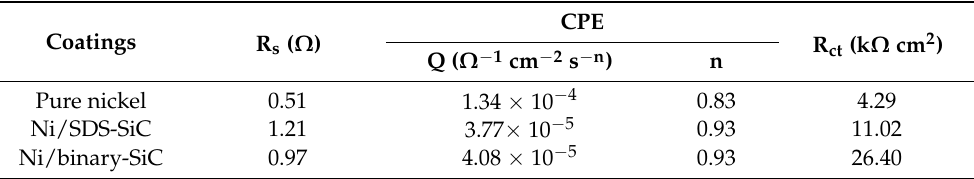
Table 3. EIS parameters obtained by electrical equivalent circuit fitting of the pure nickel, Ni/SDS-SiC and Ni/binary-SiC coatings prepared at the current density of 2.0 A dm − 2